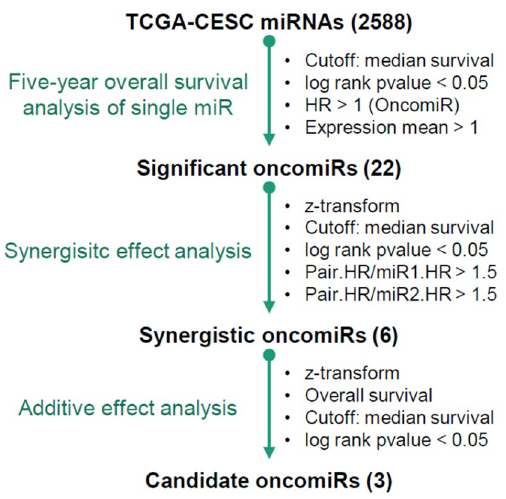
Figure 1. miRNA-seq analysis and prognostic miRNAs generation